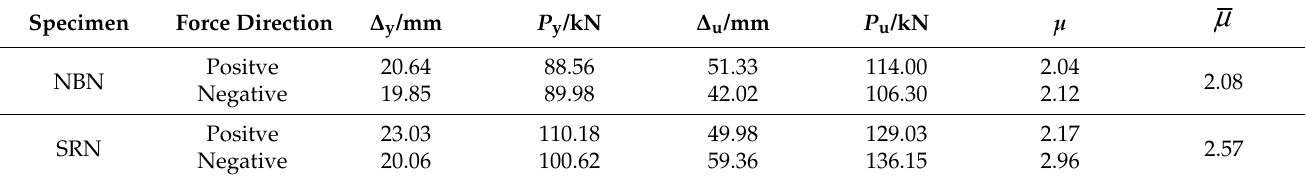
Figure 8. Calculation of schematic diagram of equivalent viscous damping ratio . Table 2. Load and displacement at characteristic points, and displacement ductility factor.